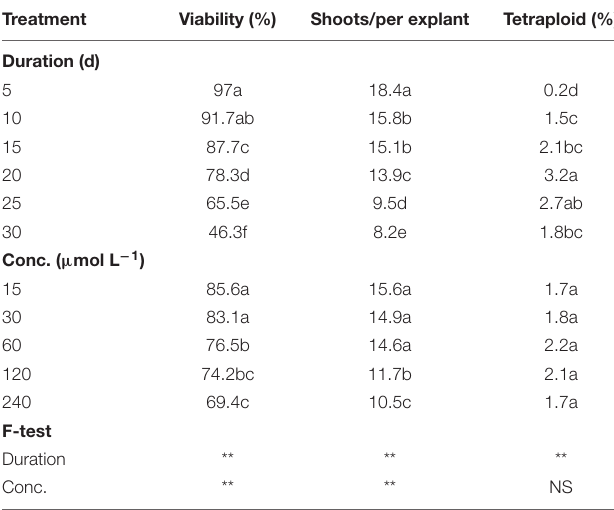
Data with different letters in the same column indicate significant difference between means at the 5% probability level by LSD. **Indicates significant difference at 0.01 level (Two-directional ANOVA and LSD’s multiple range